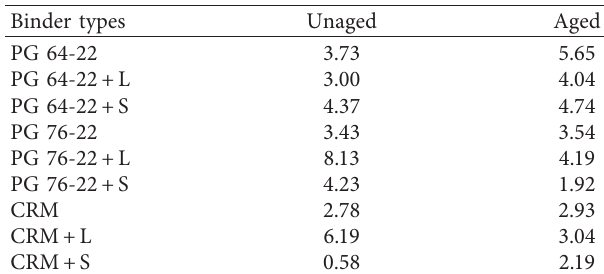
Table 4: Averaged reflectance (%) in the spectral range of 220 to 800nm.